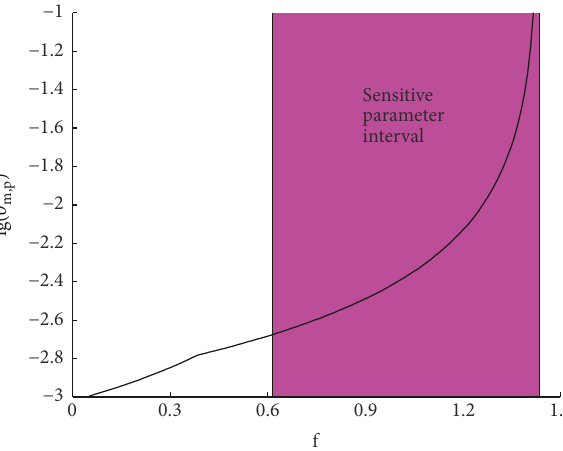
Figure 14: Influence of R on resonant peak.